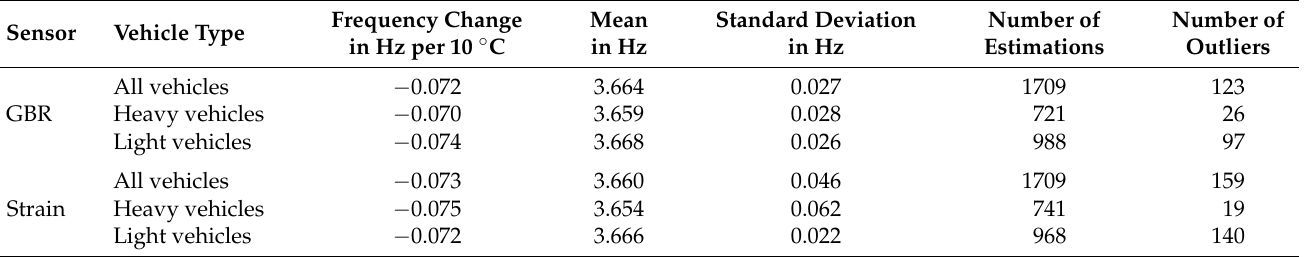
Table 5. Comparison of vehicle types for natural frequency estimation with GBR measurements analysed by the best approach . In the case of GBR, vehicles are characterised by the absolute of the peak displacement: heavy vehicles > 0.5mm, light vehicles < 0.5mm. In the case of the strain